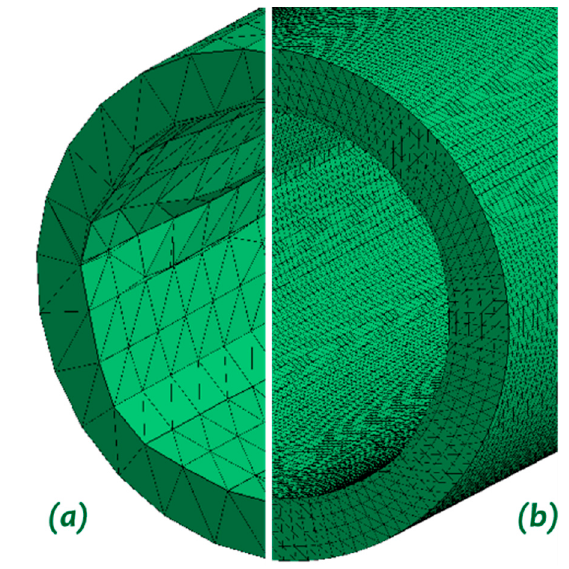
Figure 7. Mesh sensitivity analysis result.